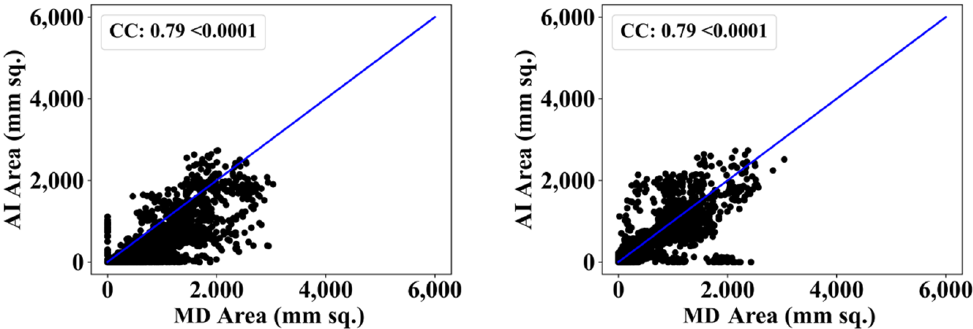
Figure 20. Correlation coefficient plots for (left) VGG ‐ SegNet vs. MD 1 and (right) VGG ‐ SegNet vs. MD 2.